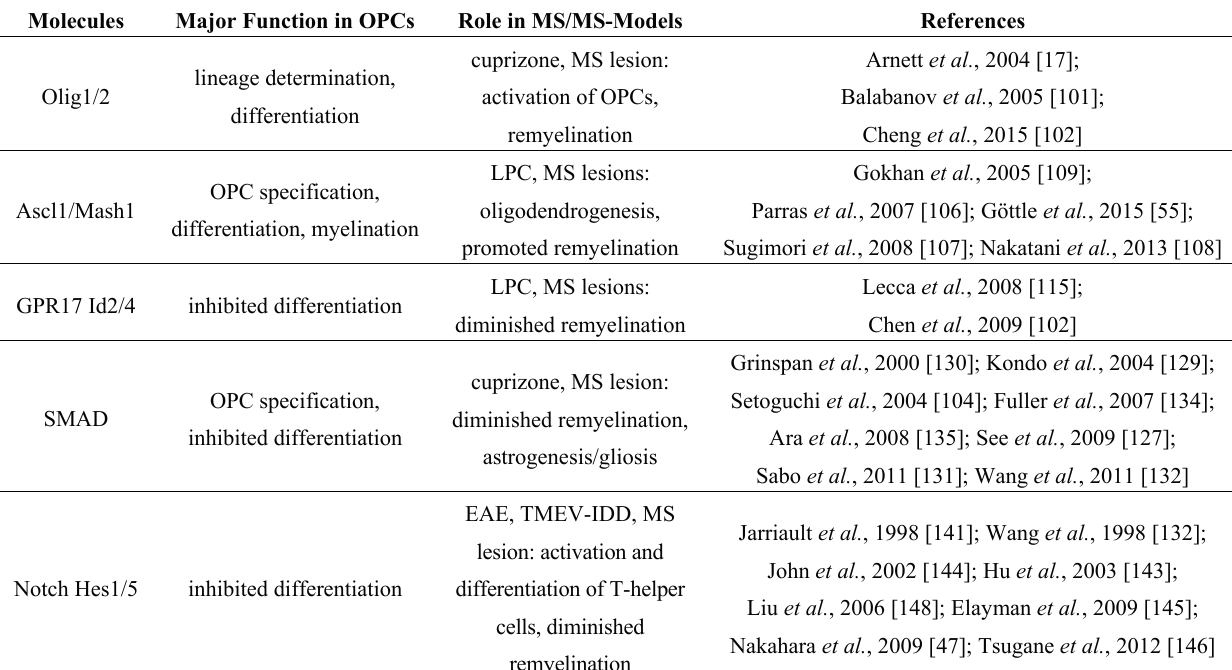
Table 2. Key transcriptional